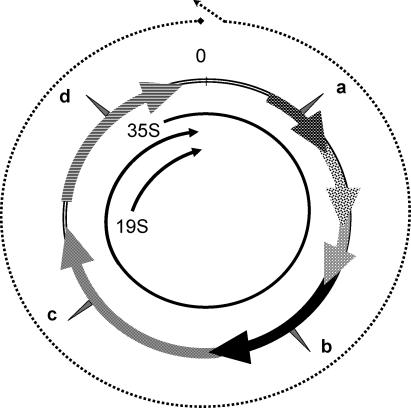
Genetic Map of CaMVThe CaMV genome is a circular double-stranded DNA of 8,024 bp, represented in the figure by a double line. The thick arrows with different textures represent the organization of open reading frames I to VI, encoding proteins detected in planta. Markers a, b, c, and d were engineered at the positions indicated (see Materials and Methods for precise positions). The inner black arrows represent monocistronic 19S RNA and polycistronic 35S RNA produced by the cellular machinery. The nucleotide position 0 (numbering according to [44]) indicates the origin of replication via reverse transcription, which occurs in the direction indicated by the dotted outermost circle-like arrow. Reverse transcription is accomplished by the viral reverse transcriptase, using the 35S RNA as template [49].